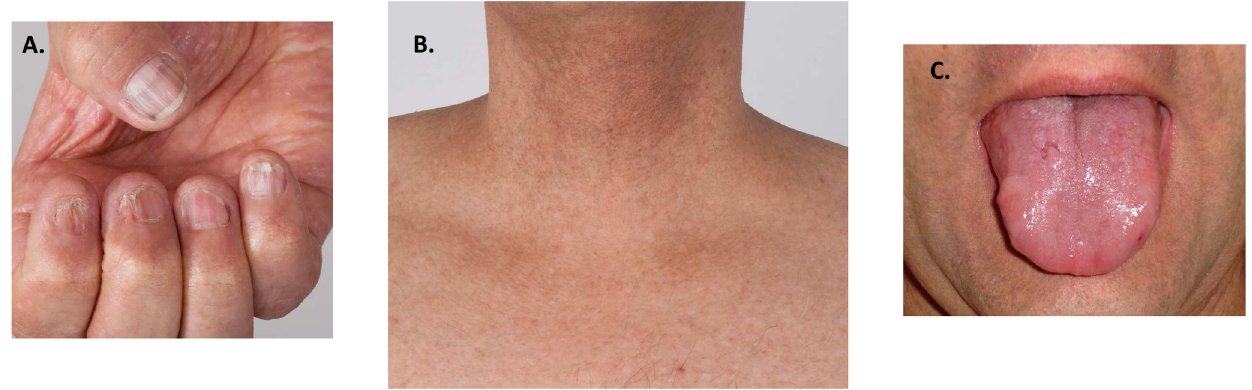
Figure 2. Mucocutaneous features of dyskeratosis congenita of an adult male whose disease is due to a DKC1 mutation. ( A ) Dystrophic and ridged fingernails. ( B ) Hyper- and hypo-pigmented skin of neck and upper chest. ( C ) Irregular leukoplakia of the tongue.